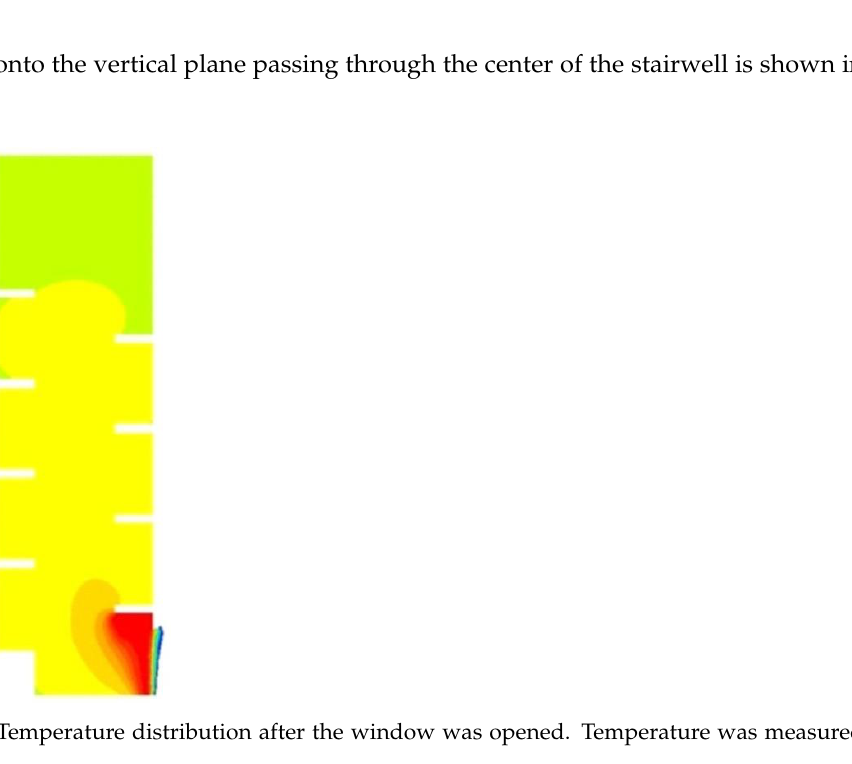
Figure 9. Carbon dioxide distribution for a closed building ( left ) and after the window was opened ( right ). Carbon dioxide was measured as a mass fraction.